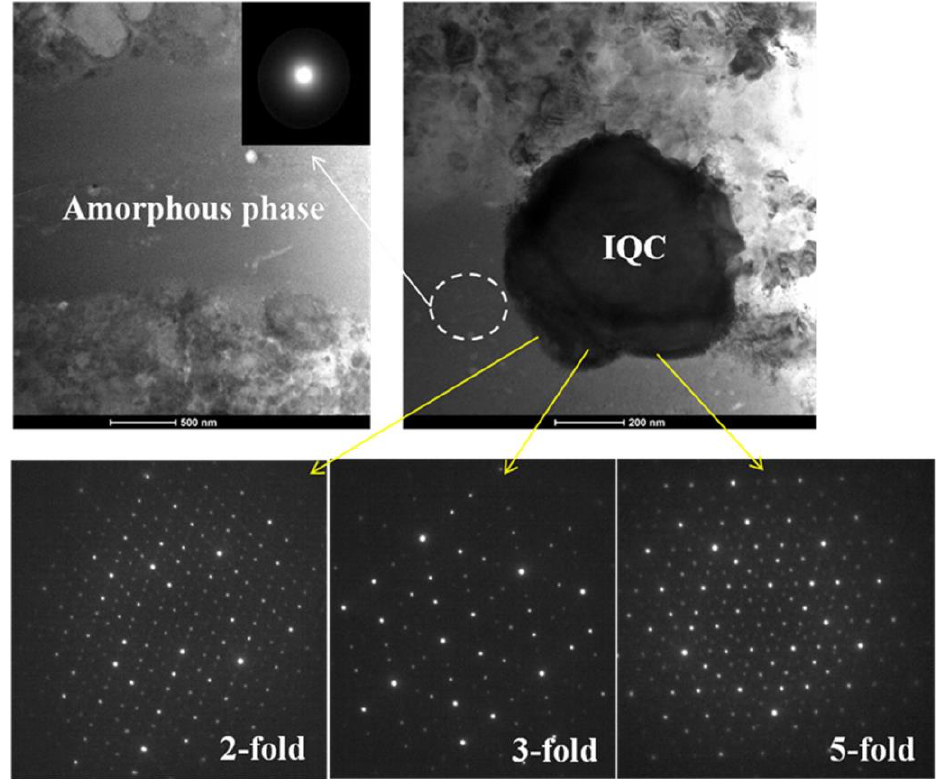
Figure 6. ( a ) Overview of coating sample for TEM investigation; ( b ) HAADF images of the amorphous and quasicrystalline phase (QC) areas; ( c ) Si-Cu-Fe maps related to ( b ).